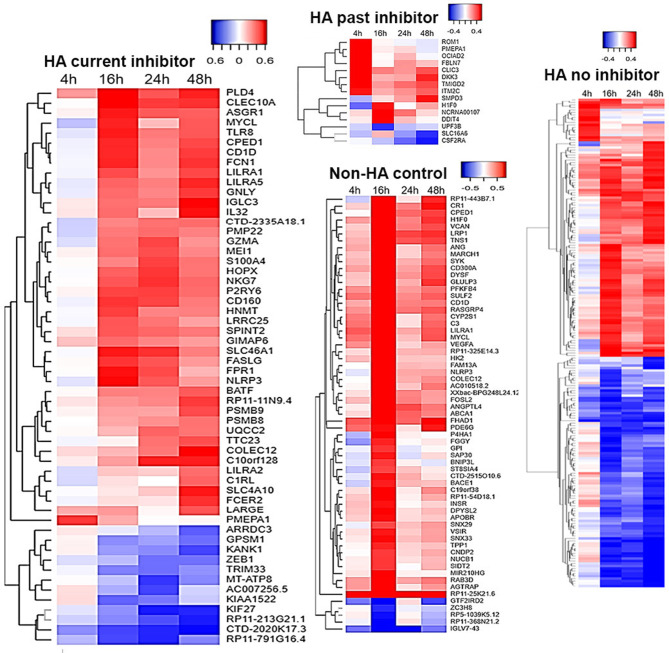
PBMC temporal transcriptome alterations following FVIII stimulation. Differentially expressed genes (DEGs) in the four groups are represented as heat maps, with units = log2 fold change (FC) vs. unstimulated baseline. Time-series differential expression analysis was performed using DESeq2. DEGs were defined as having a likelihood-ratio test (LRT) FDR <0.05 and a log2 FC > 0.322 at one or more post-stimulation time points. The FC values at each time point for each DEG are in Supplemental Table 3.